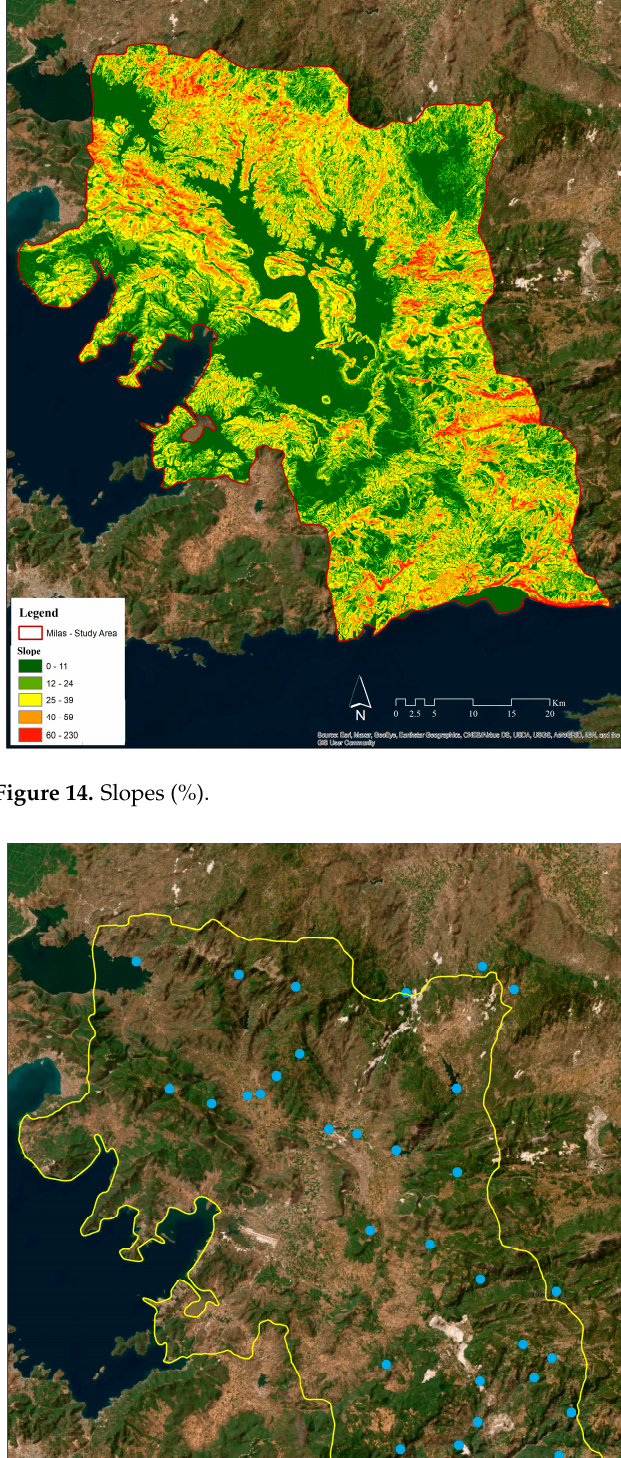
Figure 13. Elevations (m).